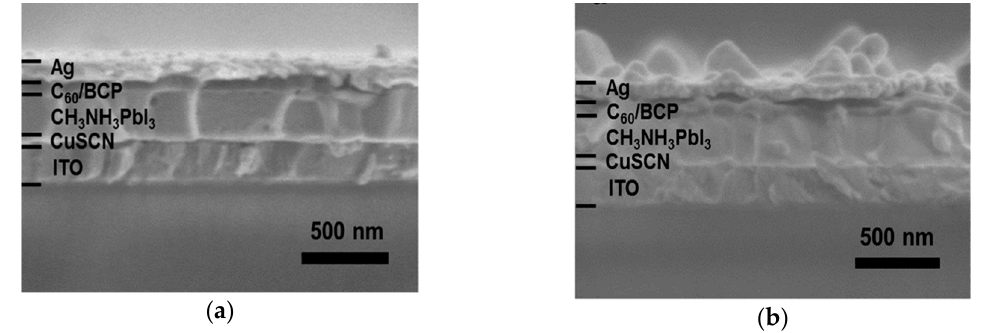
Figure 9. ( a ) SEM cross-sectional image of a device fabricated with one-step fast deposition technique; ( b ) SEM cross-sectional image of a device fabricated with the two-step technique deposition technique. Reproduced with permission from Reference [72]. American Chemical Society 2015. Table 4. The photovoltaic performance of Device A and B deposited using different techniques.